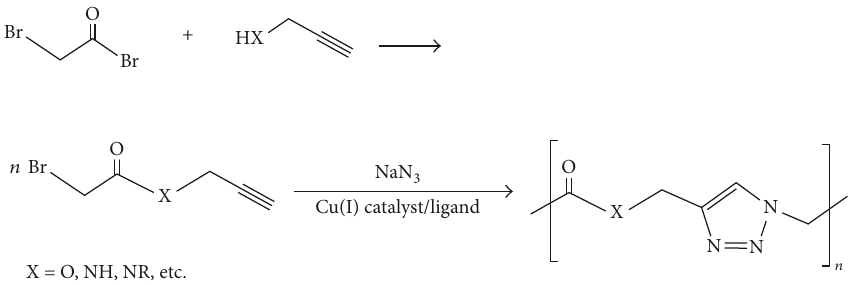
Figure 3: Scheme of the synthesis of AB-type click polymers.